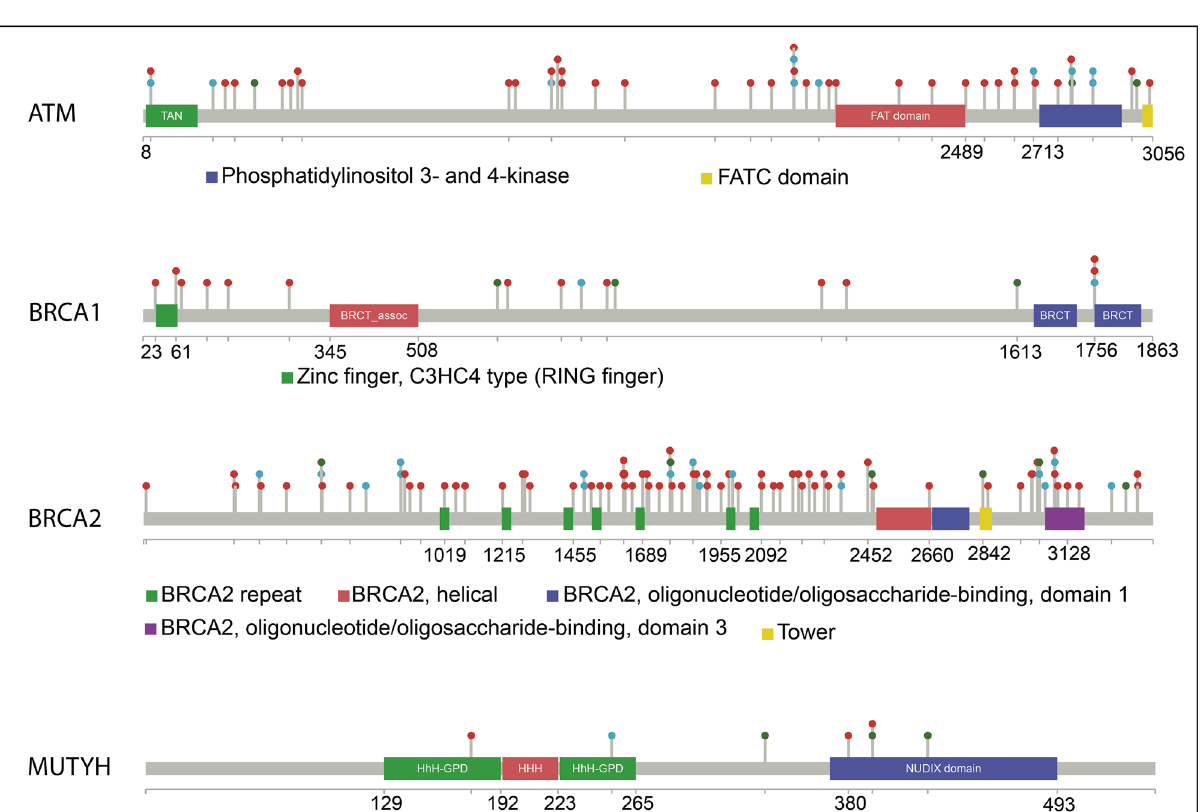
Figure 5. Lollipop diagrams of germline and somatic variants in ATM, BRCA1, BRCA2 and MUTYH. The locations of different types of variants along the protein sequences are indicated by the coloured “lollipops”. The variants are coloured: red for pathogenic germline variants identified in different cohorts of advanced PCa, cyan for recurrent germline and somatic variants in PCa, and green for hotspot positions in different tumour